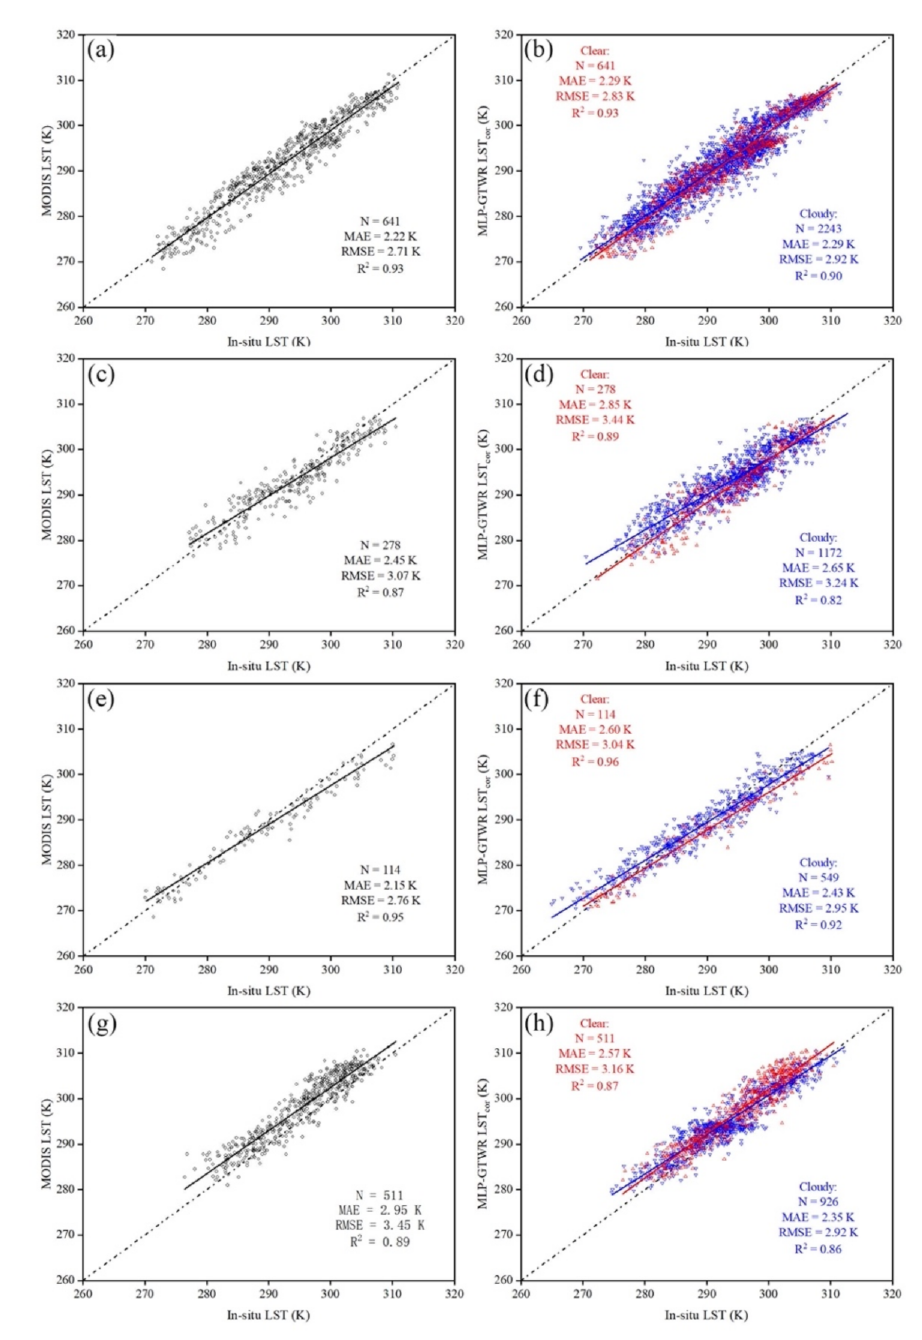
Figure 4. Scatterplots of the MODIS LST and the MLP-GTWR LST cor against the in situ LST at four flux stations with valid data number (N), MAE, RMSE, and R 2 . The left side is the MODIS LST, and the right is the MLP-GTWR LST cor . ( a , b ) Qianyanzhou, ( c , d ) Dinghushan, ( e , f ) Taoyuan, and ( g , h )